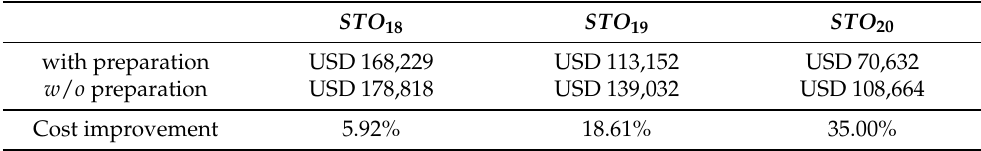
Table 3. Total MG operation costs according to STO l in Case